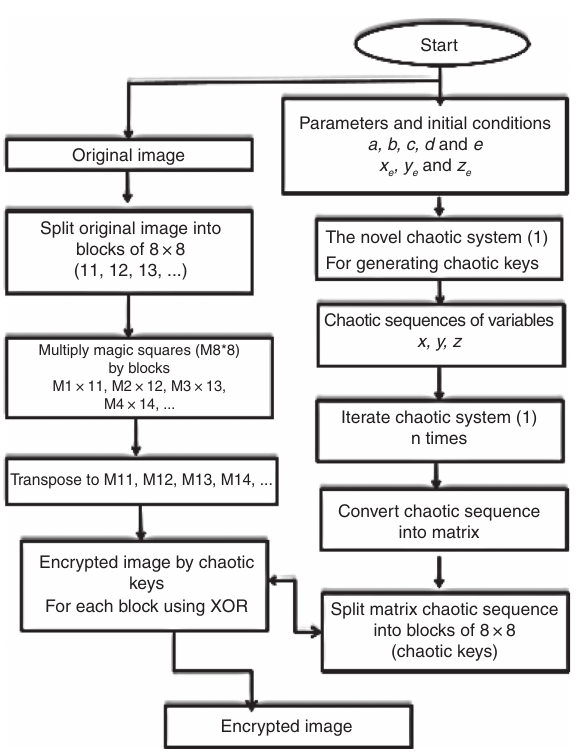
Figure 8: Proposed Algorithm Diagram of the Chaotic Encryption